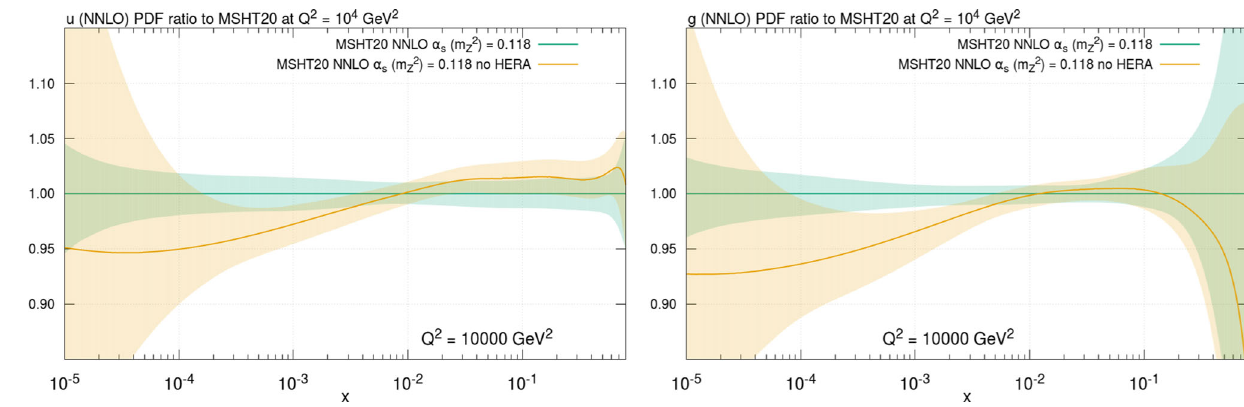
Fig. 79 (Left) u PDF ratio and (right) g PDF ratio at Q 2 = 10 4 GeV 2 at NNLO showing the effect of removing the HERA data from the MSHT20 default global